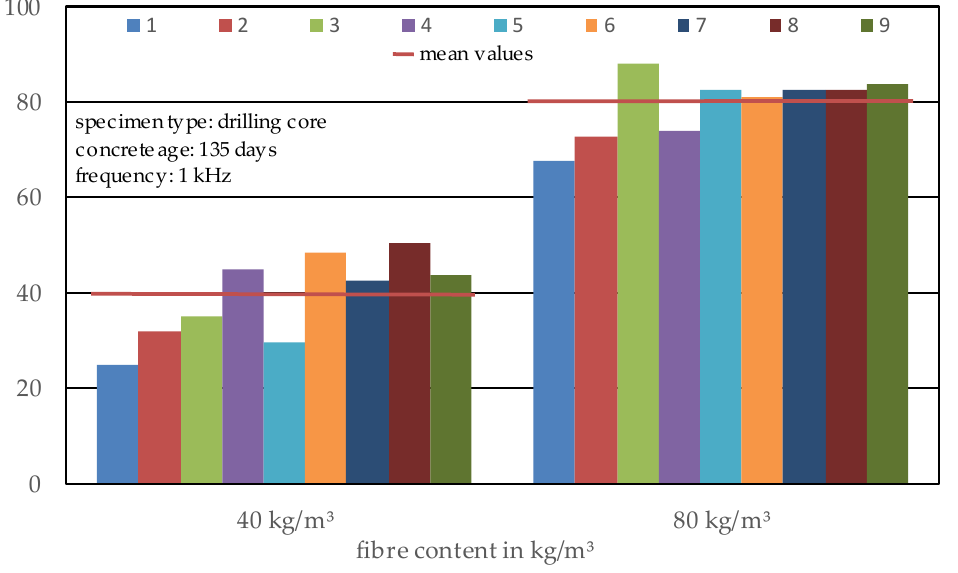
Figure 15. Calculated fibre content of the drilling cores depending on the fibre content by use of the adjusted fibre aspect ratio.